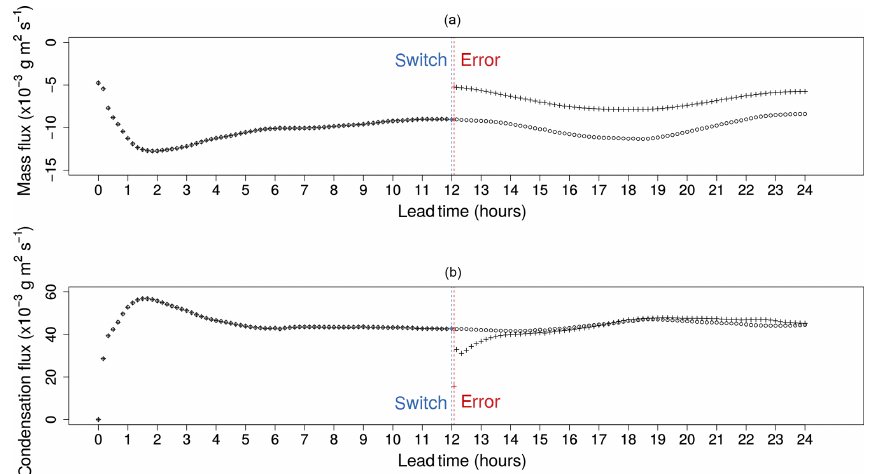
Figure 4. Domain averaged total transport fluxes, J td v + J c v (open circles) and J (cid:48) td v (crosses), for water vapour (a) and total condensation fluxes + F c ( F st and F (cid:48) st vl ) for cloud water (b) . Both forecasts are started at 12:00UTC on 5 April 2009 with deep-convection parameterization; vl vl after 12h (blue dashed vertical line) the deep-convection scheme is deactivated and both forecasts continue for another 12h. The differences between the fluxes are diagnosed after one time step (red dashed vertical line).